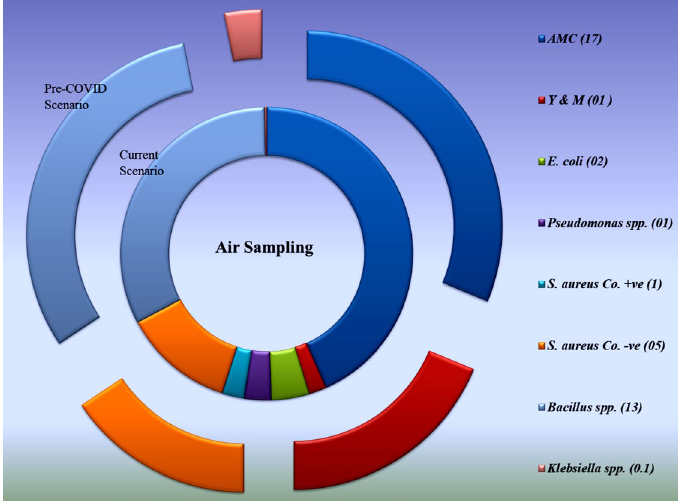
Fig. 1. Comparison of air samplings collected during pre-COVID and current scenario along with the isolation